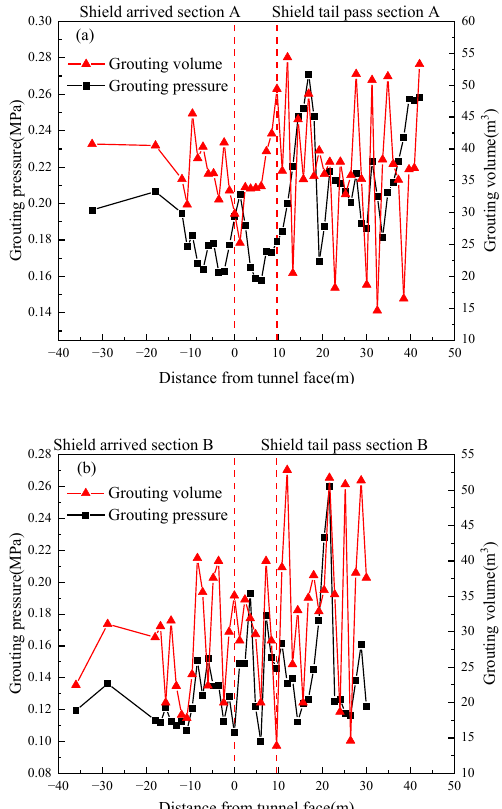
Figure 15. The relationship between grouting pressure and grouting volume: ( a ) south line; ( b ) north line.